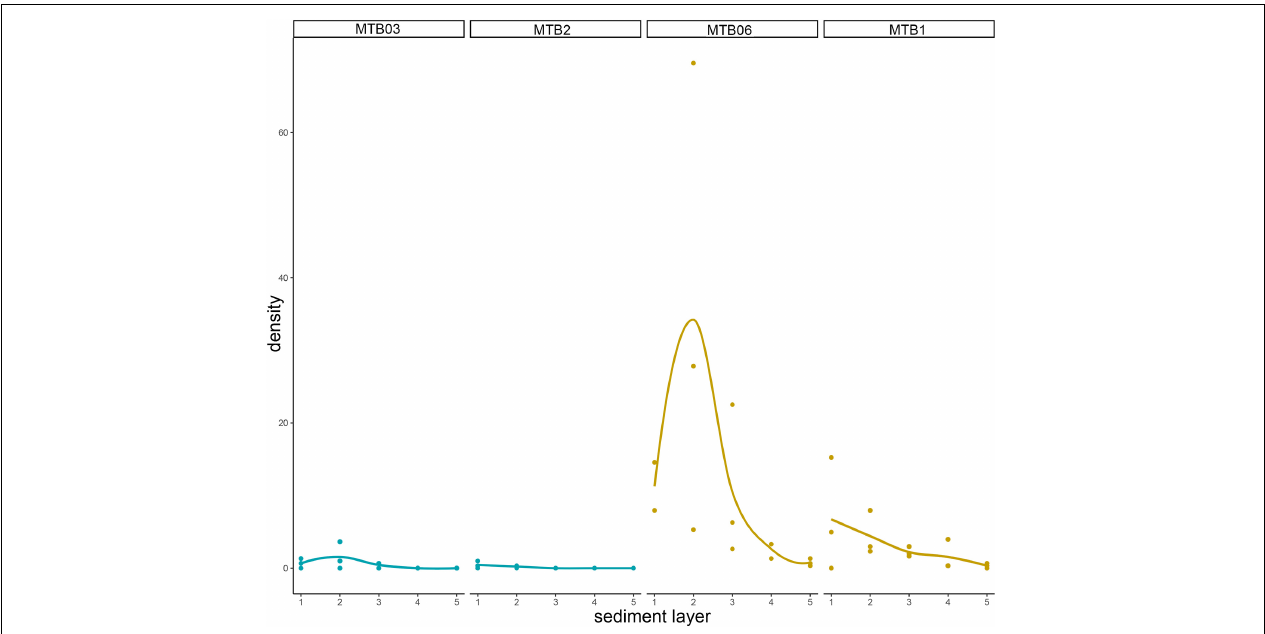
FIGURE 11 | Kinorhynch total density (including both adults and juveniles) along the vertical profile of the four study sites: MTB03 and MTB2 as outside pockmark sites (blue), and MTB06 and MTB1 (purple) as inside pockmark sites (yellow). Layers per core were determined as follows: layer 1 (0–1 cm), layer 2 (1–2 cm), layer 3 (2–3 cm), layer 4 (3–4 cm), and layer 5 (4–5 cm).